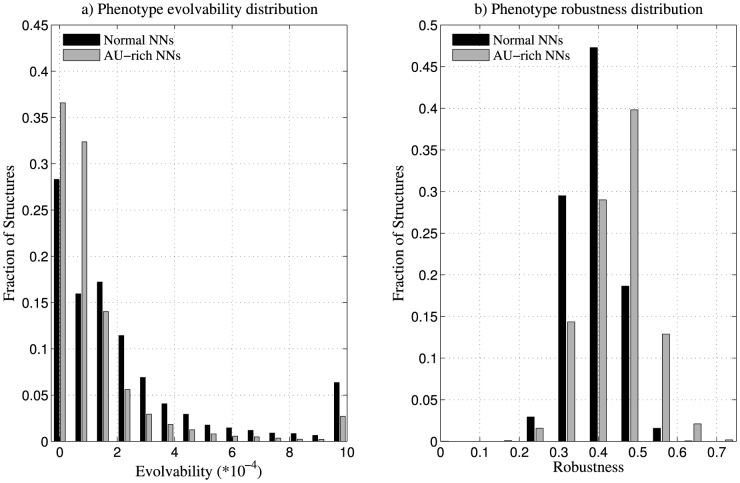
Comparison of phenotype robustness and evolvability of normal and AU-rich sequences.(a) Histogram of phenotype evolvability of AU-rich and normal neutral networks (NNs) of 2.5×104 structures. We observe that AU-rich neutral networks, in general, have lesser phenotype evolvability in comparison to normal neutral networks. (b) Histogram of phenotype robustness of AU-rich and normal neutral networks (NNs) of 2.5×104 structures. We observe that AU-rich neutral networks, in general, have higher phenotype robustness in comparison to normal neutral networks. These neutral networks are weighted using κ = 2.5.